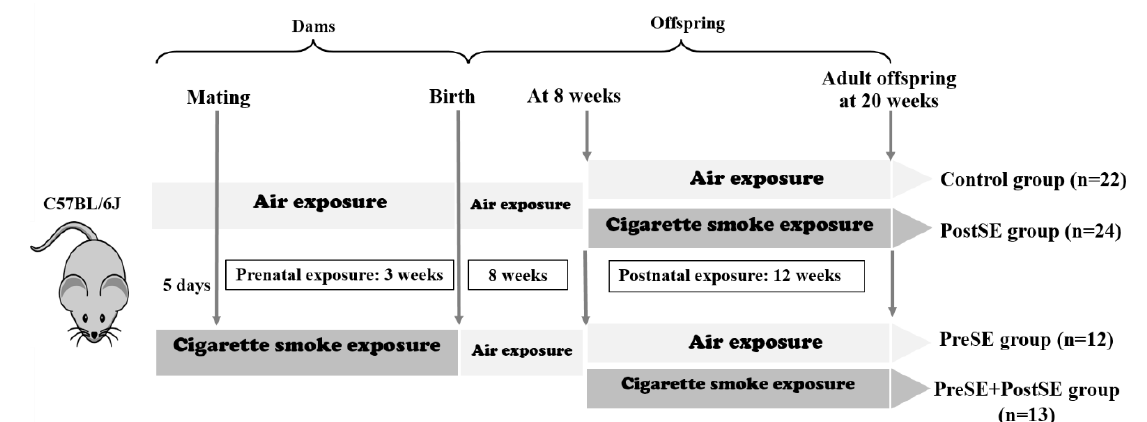
Figure 5. Study plan. The exposed offspring are divided into four group, which are air exposed offspring (control, n = 22), postnatal smoke exposed offspring (PostSE, n = 24), prenatally smoke exposed offspring (PreSE, n = 12), and the combined with prenatally smoke exposed and postnatal smoke exposed offspring (PreSE/PostSE, n = 13). Arrows indicate periods of exposure to air exposure (open box) and cigarette smoke exposure (closed box).